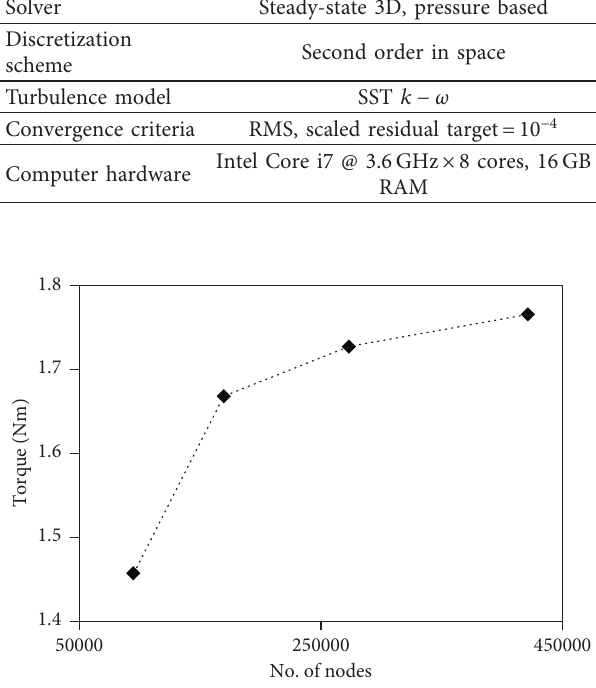
Figure 7: Study for mesh independence.